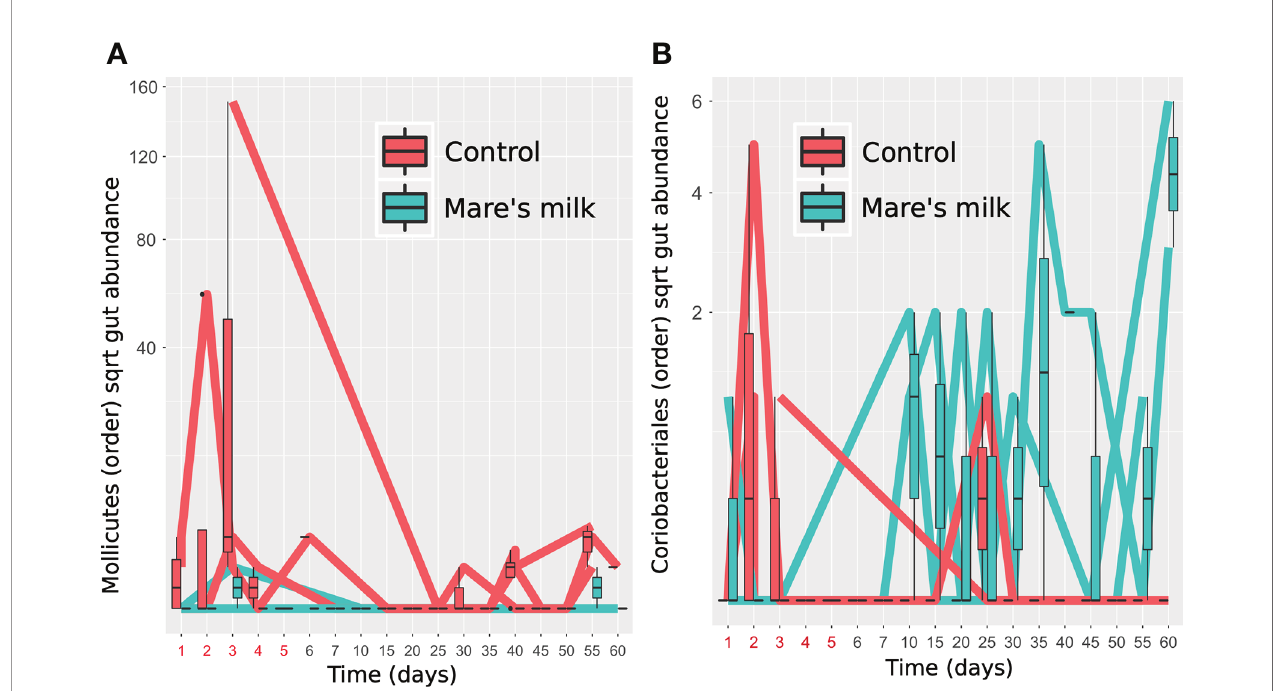
FIGURE 4 | Speci fi c gut orders enriched and depleted. Two bacterial orders show signi fi cantly altered abundance between MM-treated subjects and controls in post-antibiotic samples (replicates removed) tested using nested mixed models compared using a likelihood ratio test, controlling for donor as random effect, timepoint and stool vs. swab as fi xed effects. (A) Figure shows Mollicutes gut abundance of the subjects, labeled red (N=3, controls) or blue (N=3, MM), shown as time trajectories and boxplots. (B) Figure shows Coriobacteriales gut abundance of the subjects, labeled red (N=3, controls) or blue (N=3, MM), shown as time trajectories and